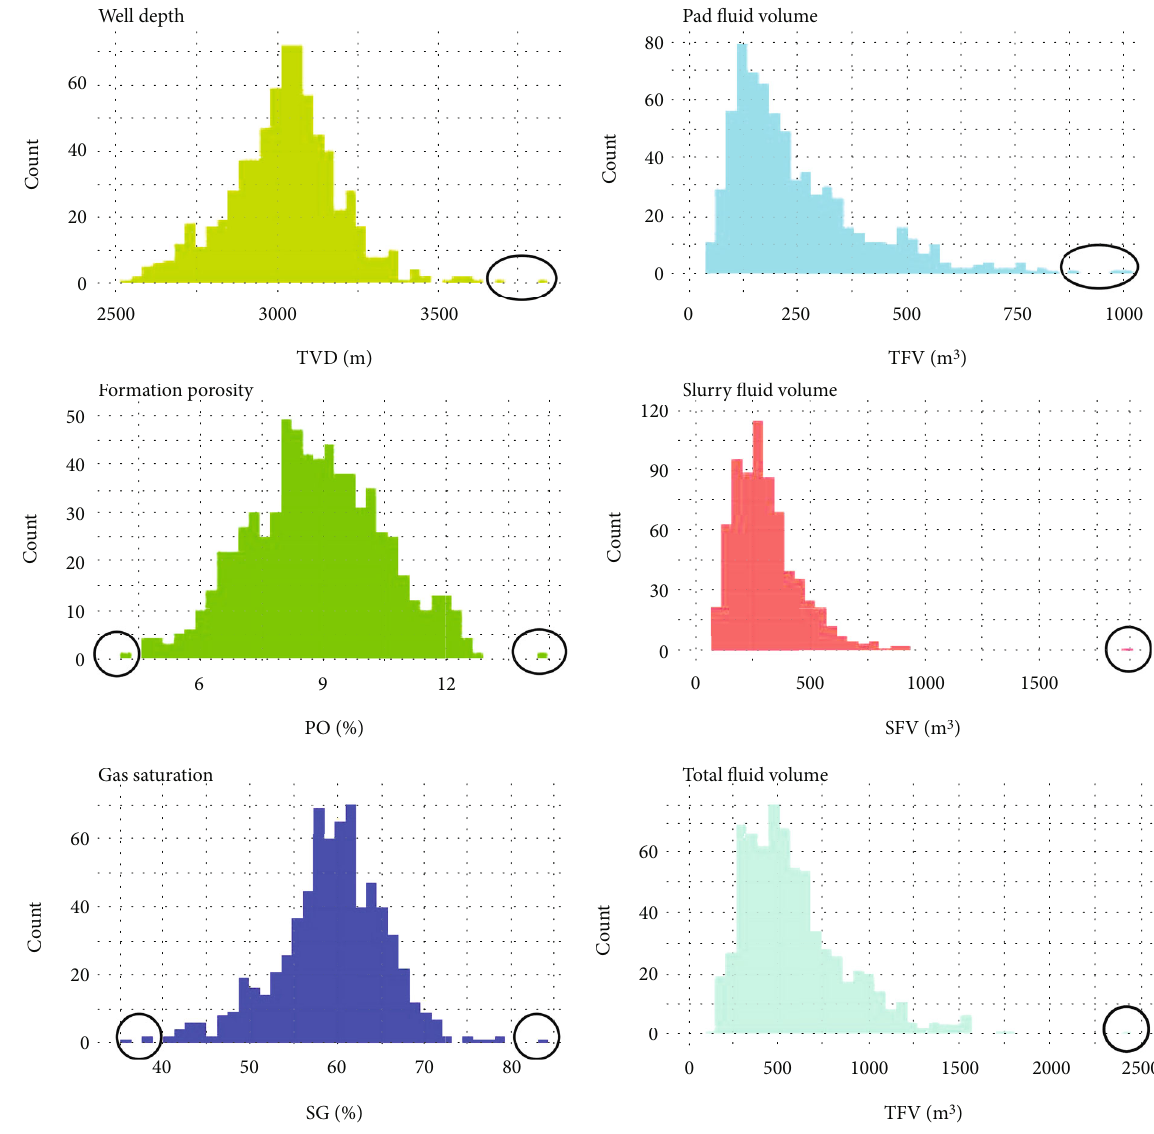
Figure 3: Histograms of the main